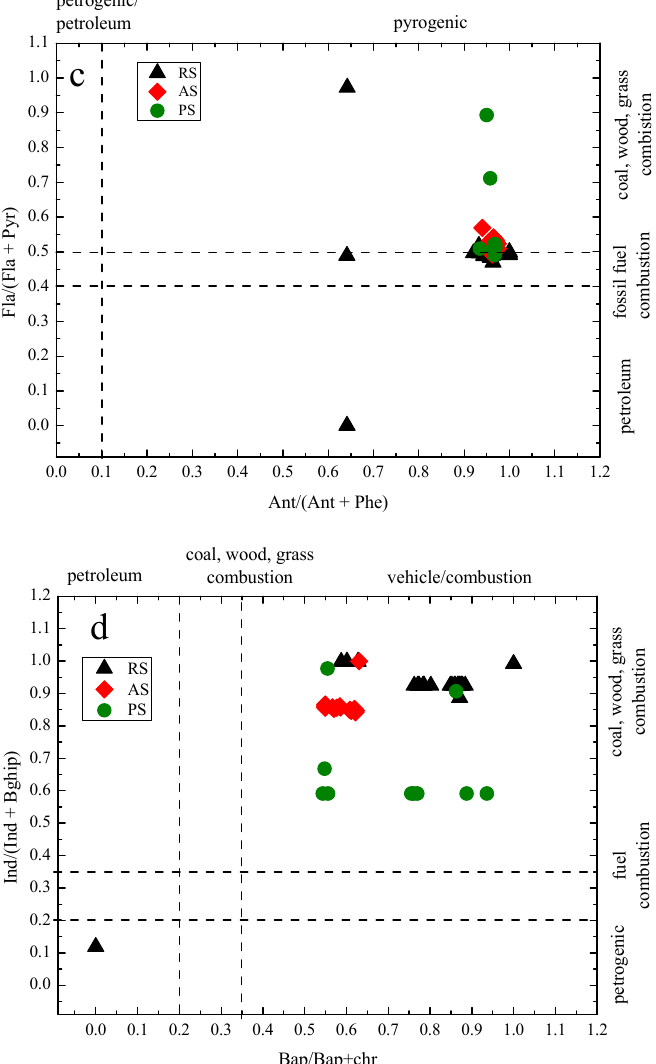
Figure 5. Diagnostic ratio charts for ( a ) HMW/LMW and Fla/Pyr, ( b ) Baa/(Baa + Chr) and Phe/Ant, ( c ) Fla/(Fla + Pyr) and Ant/(Phe + Ant), and ( d ) Bap/(Bap + Chr) and Ind/(Ind + Bghip) in the sample soils around the chemical plant.